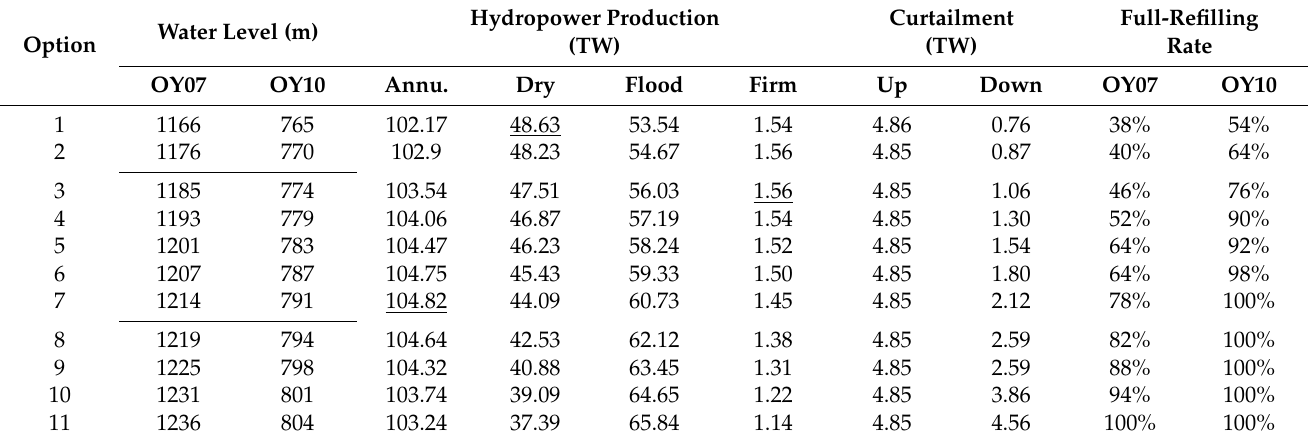
Table 2. The performances of optional drawdown levels at the end of